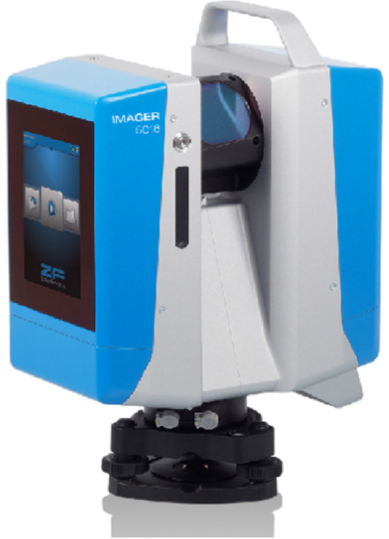
Figure 4. Schematic diagram of the coordinates of the main sensors of TMLS.